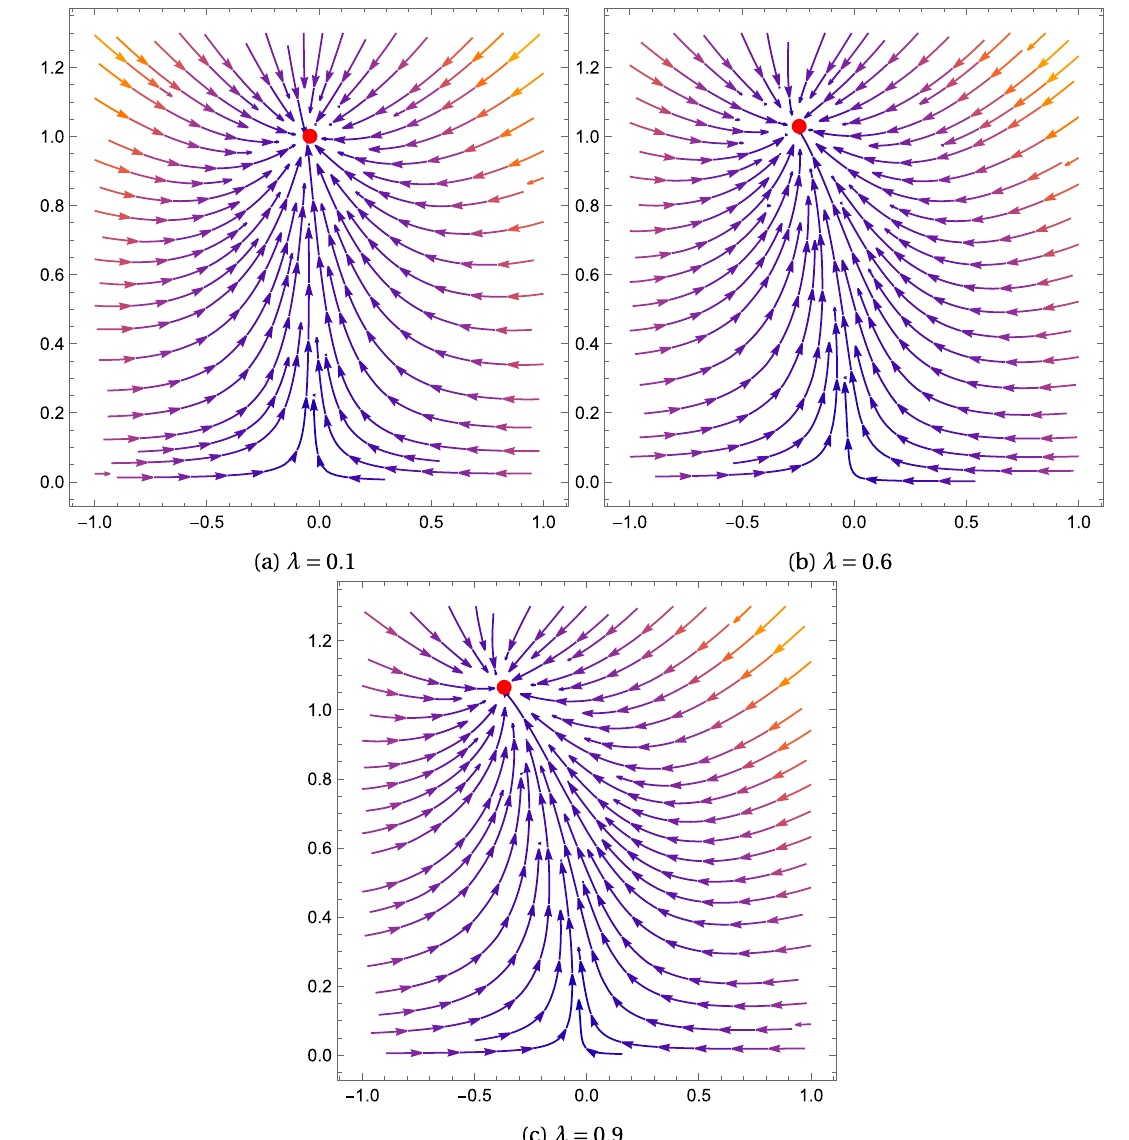
Fig. 6 The phase space portraits of the dynamical system for an equilibrium point D for λ = 0 . 1, λ = 0 . 6 and λ = 0 . 9 with a coupling constant ‘C’ = 0.04. The horizontal axis represents variable ‘x’ and vertical axis represents variable